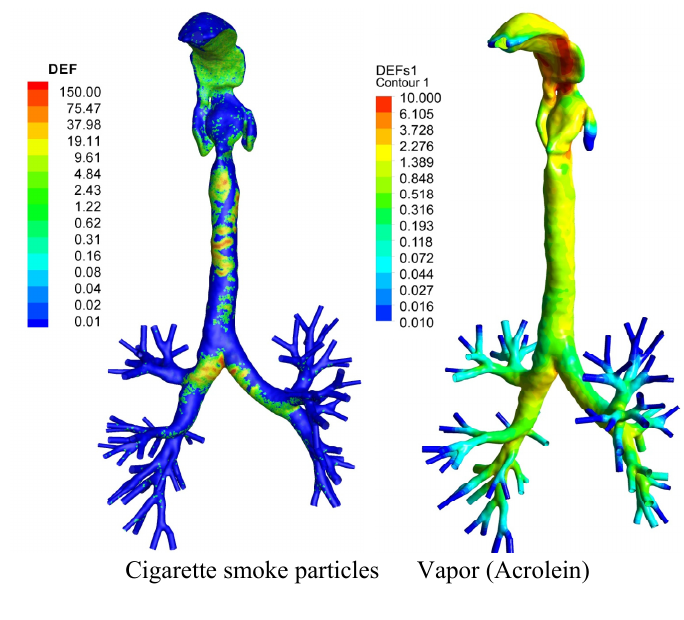
Figure 2. Local deposition patterns of CSPs and acrolein vapor under steady inhalation (Reprinted from [12,13], with permission from